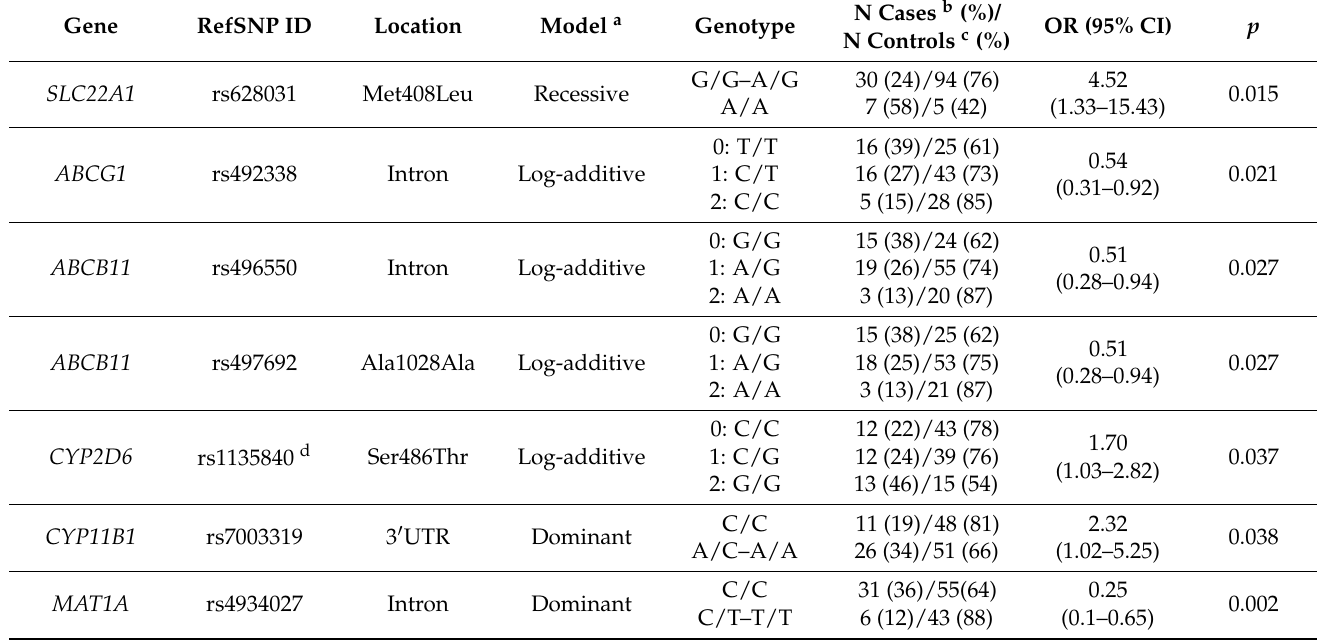
Table 2. SNVs significantly associated ( p < 0.05) with MMR achievement with imatinib first-line treatment in the extended cohort. Genetic model of inheritance and genotype are indicated in each